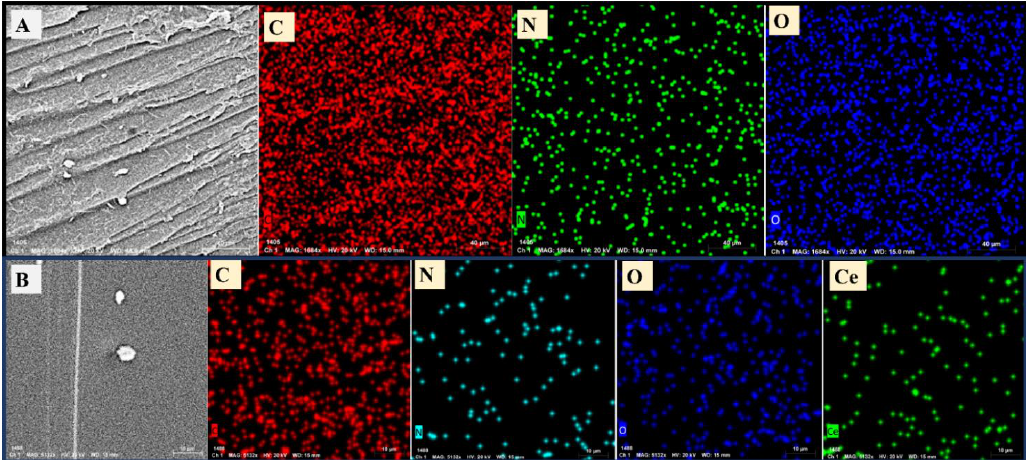
Figure 3. Chemical mapping by FESEM of gelatin ( A ) and 5% CeO 2 @gelatin ( B ), and the mapping images include the mapping of C, N, O for the gelatin sample and C, N, O, and Ce for the 5% CeO 2 @gelatin sample.